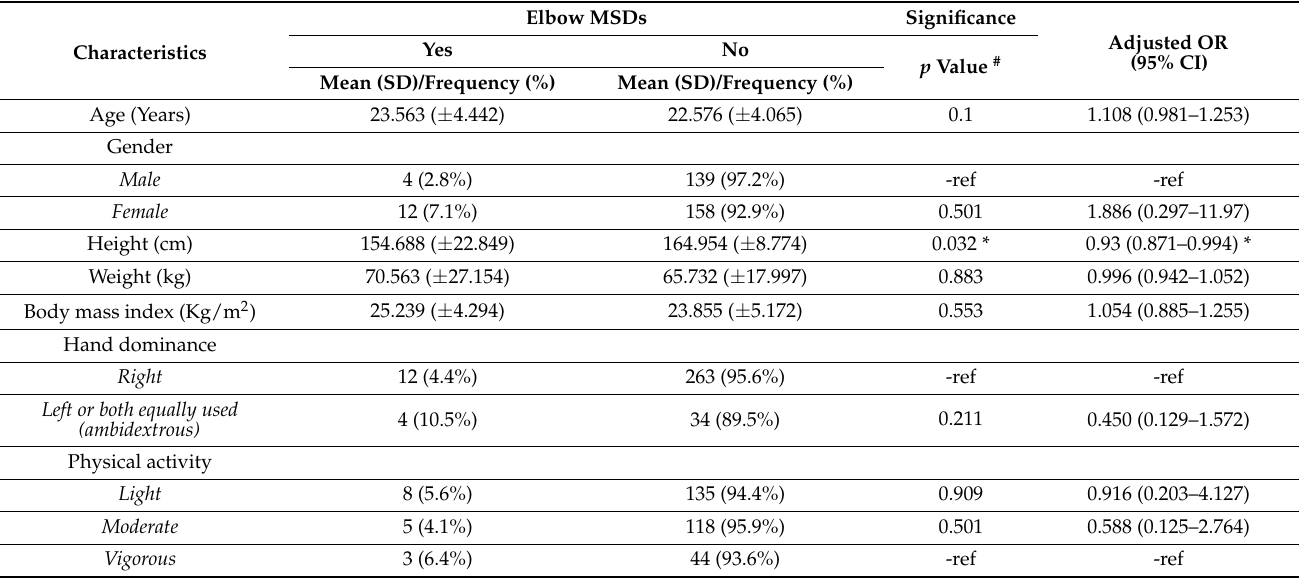
Table 5. Association between elbow MSDs and participant characteristics.